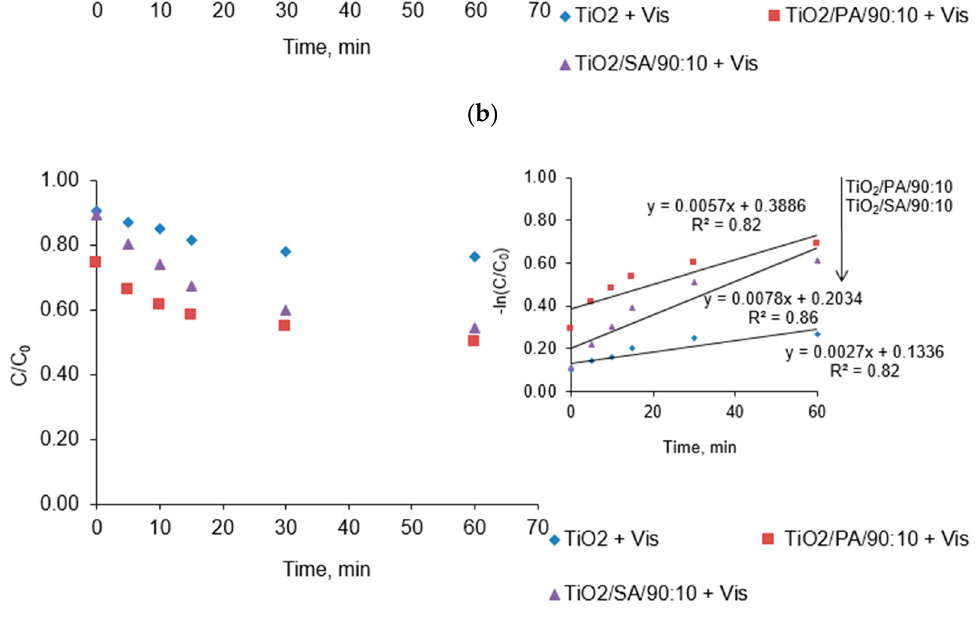
Figure 8. Reduction in the initial concentration of CFVP in the model solution at ( a ) pH = 3.0, ( b ) pH = 6.0, ( c ) pH = 9.0. Conditions of experiment: C 20.0 min; t ir = 60.0